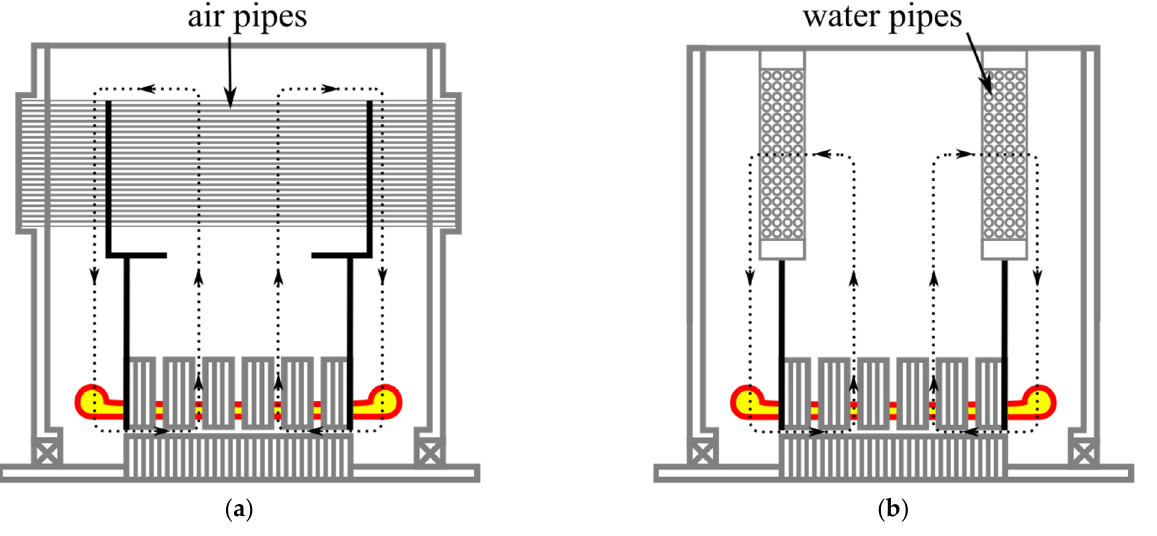
Figure 25. TEAAC and TEWAC coolers [87,123–125]: ( a ) TEAAC (CACA) cooler; ( b ) TEWAC (CACW) cooler.